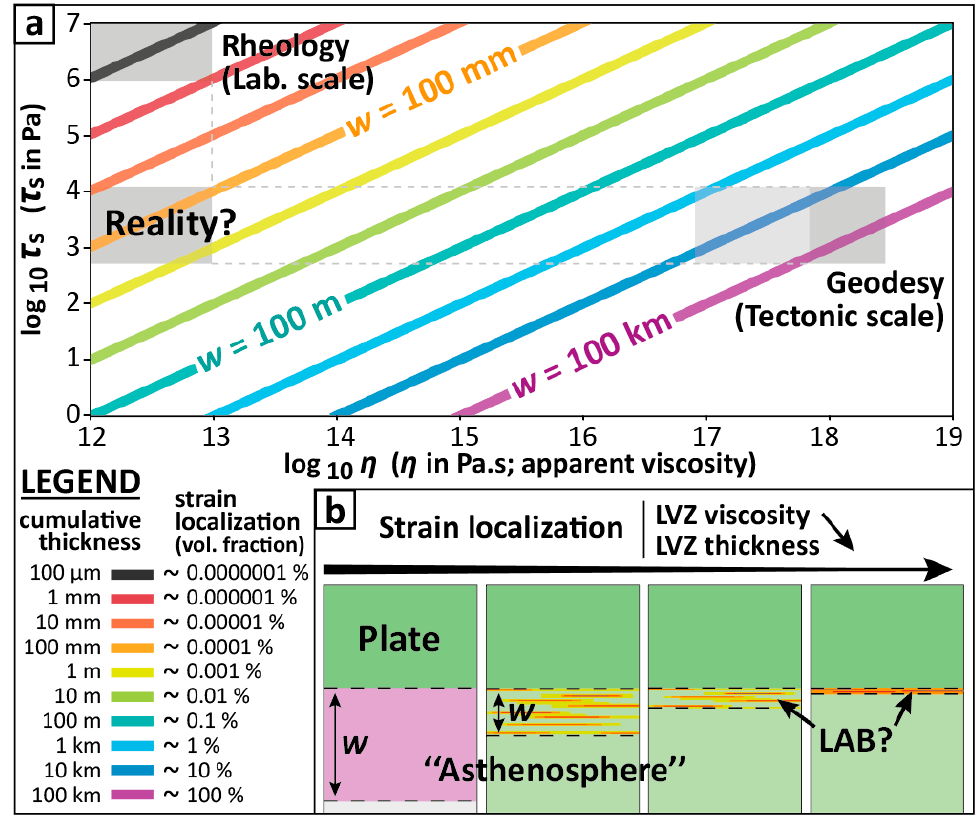
Figure 13. The “asthenosphere” apparent viscosity in question. ( a ) Shear stress at the base of the tectonic plates as a function of the apparent viscosity and thickness ( w ) of the low-viscosity zone (LVZ) considering the latter as a Newtonian fluid, with comparison between tectonic-scale and laboratory points of view; ( b ) Sketch (not to scale) illustrating the trade-off between the LVZ thickness and its (apparent) viscosity. “Strain localization” accounts for potential inhomogeneous distribution of the decoupling process, and is given in percentages of an arbitrary 100-km-thick asthenosphere.